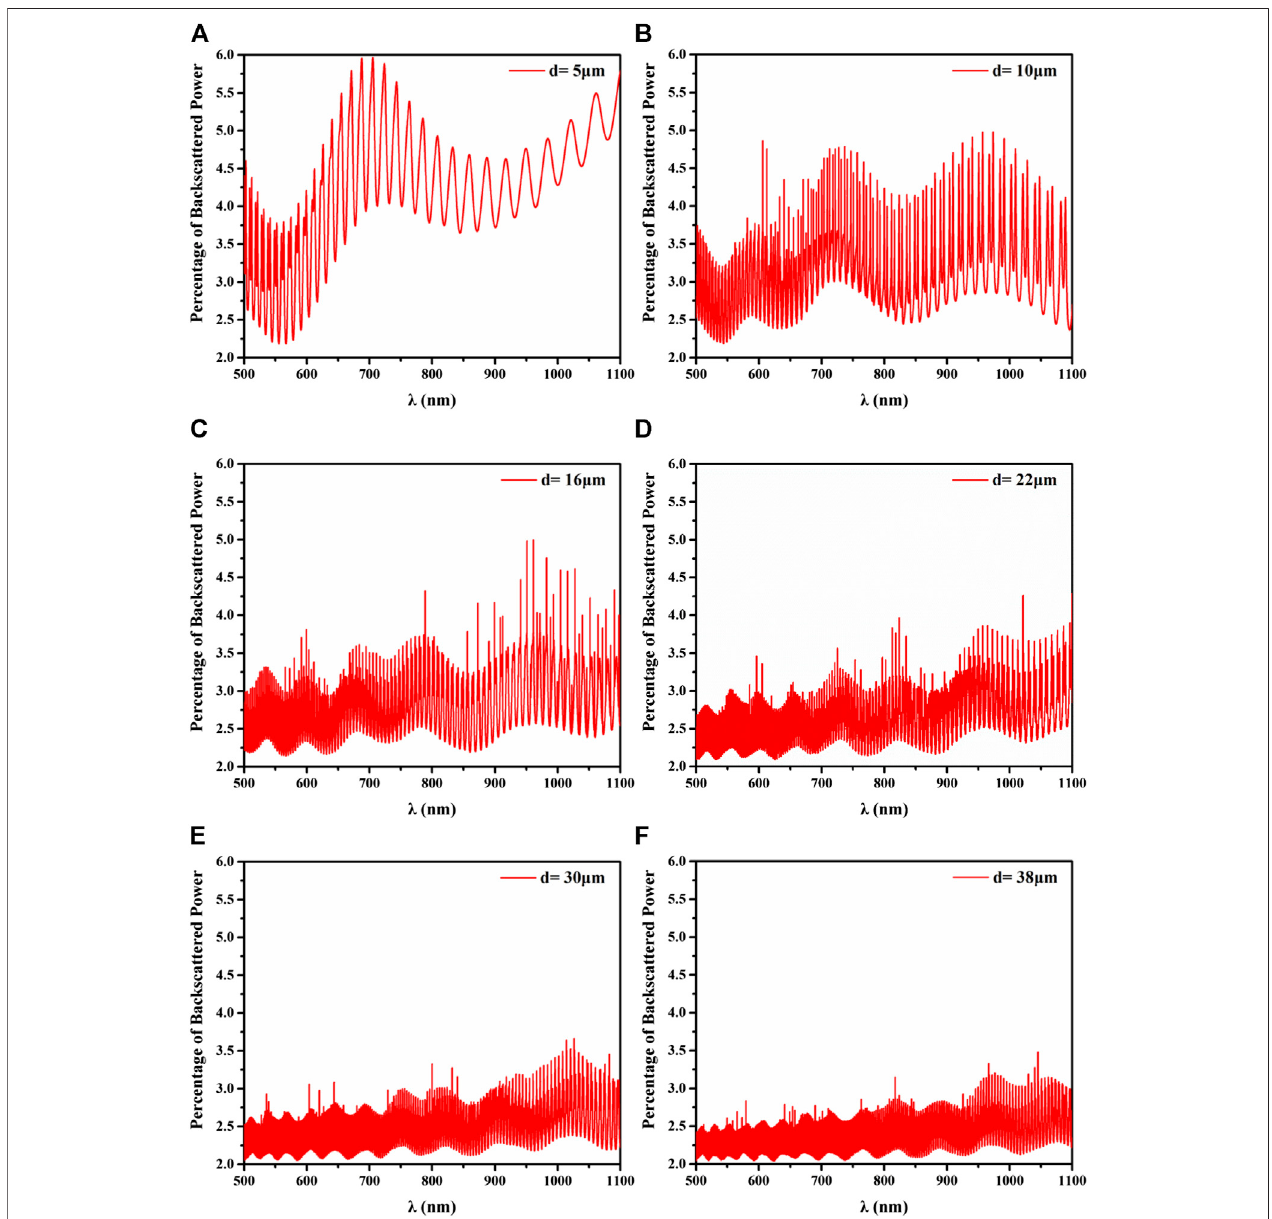
FIGURE 3 | The percentage of backscattered power of LDS particles at the different wavelengths in EVA fi lms (A – F) .